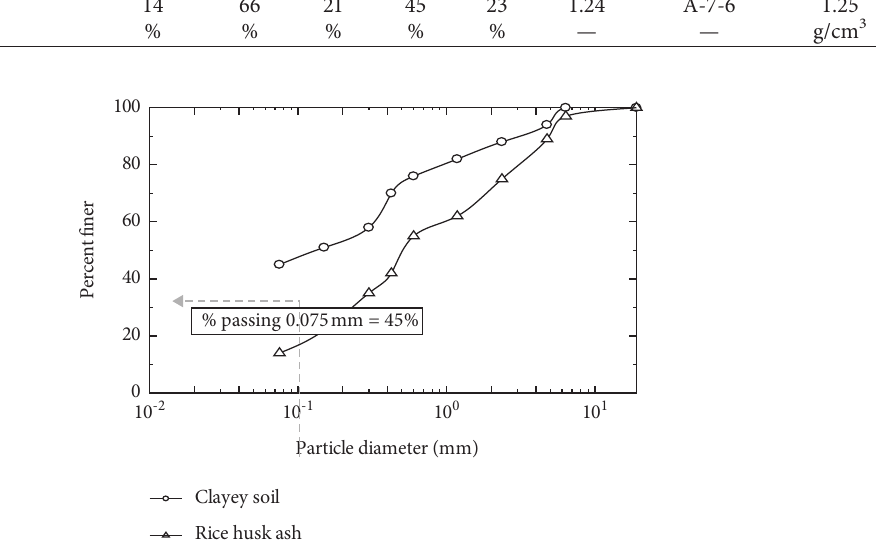
Figure 2: Particle size distribution curve of clayey soil and rice husk ash [13, 26].